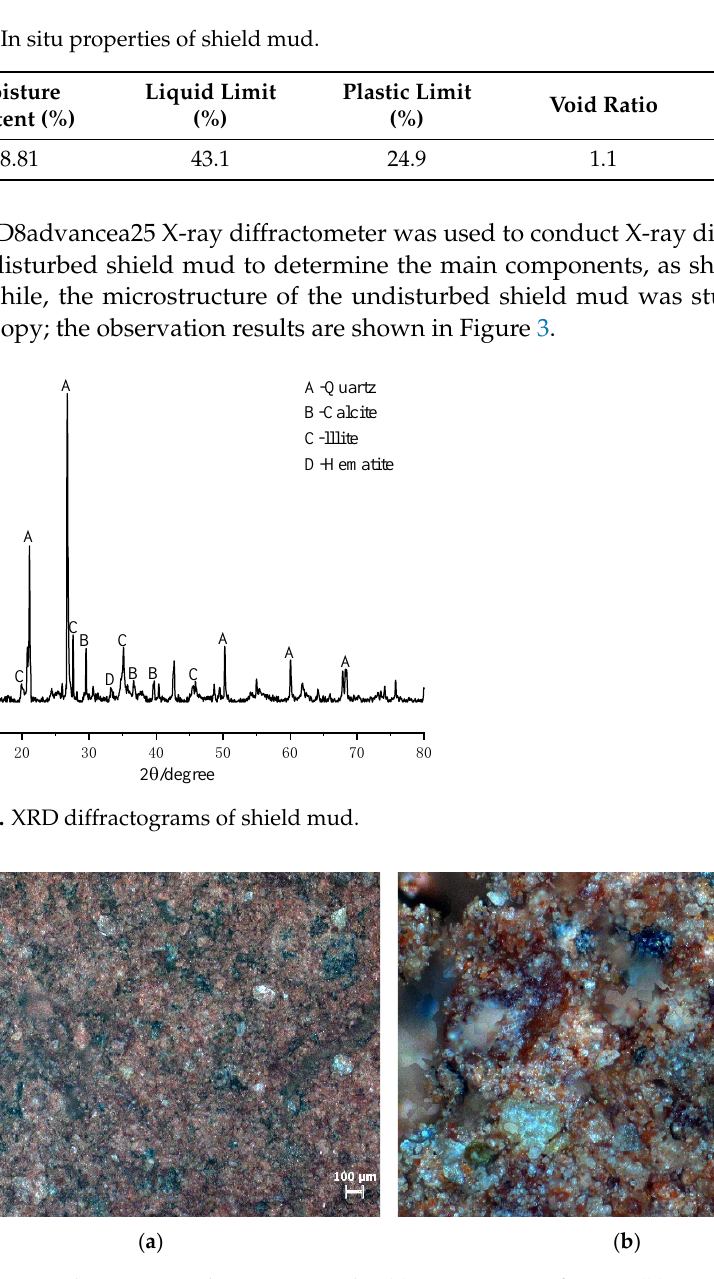
Figure 3. Optical microscope observation results. ( a ) 50 times magnification; ( b ) 200 times magnifi- cation.